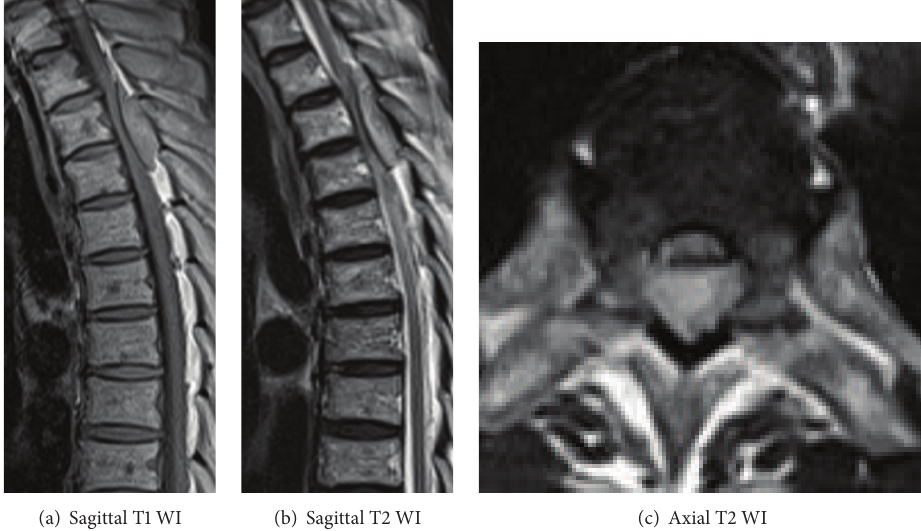
Figure 1: Thoracic spine MRI before operation. A thoracic epidural mass lesion was evident showing low intensity on the T1 weighted image and iso-high intensity on the T2 weighted image.